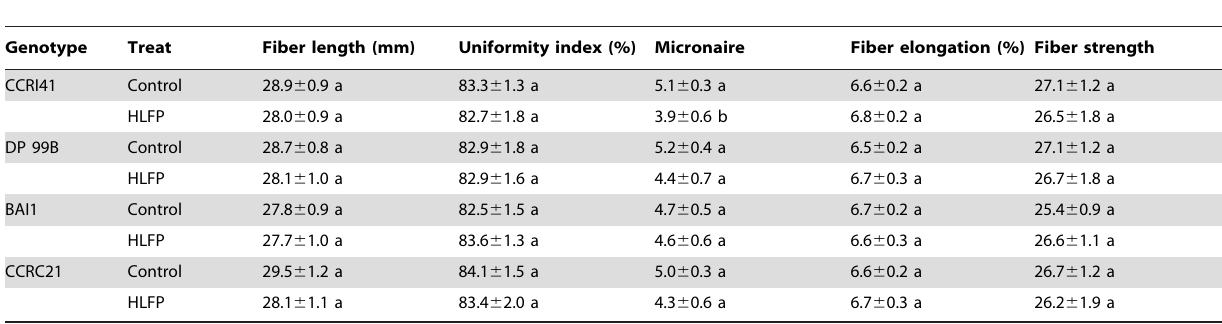
Table 7. Effects of mechanical stress caused by hanging labels from the petioles (HLFP) of every white flower in the field on fiber quality expressed as fiber length, uniformity index, micronaire, fiber elongation and strength in four cotton genotypes.